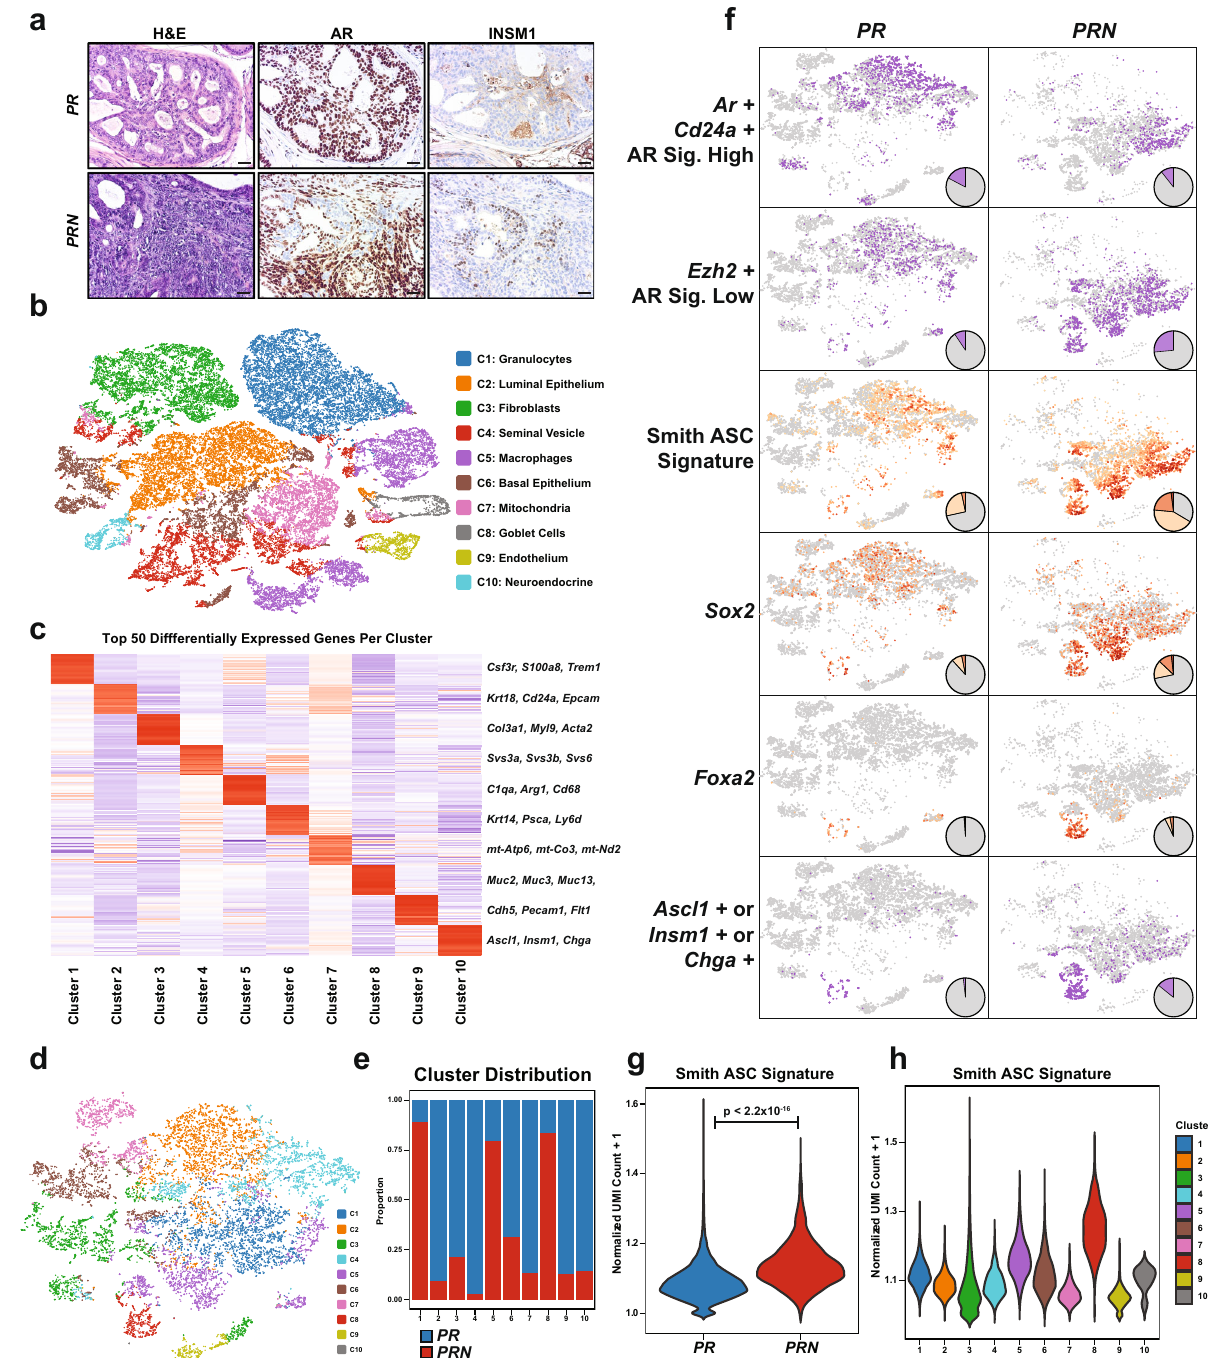
Fig. 3 Single cell-based approaches reveal NEPC-like subpopulations. a H&E and IHC staining of AR and INSM1 in samples used for scRNA-seq. Scale bar: 50 μ m. b The combined t-SNE plot of scRNA-seq data from intact PR ( n = 3) and PRN ( n = 3) mice. c Clustering of the top 50 most differentially expressed genes between clusters. d Reclustering of combined luminal, basal, and neuroendocrine populations from PR ( n = 3) and PRN ( n = 3) mice. e Distribution of genotypes between clusters identi fi ed in panel d . f Expression of indicated markers or signature in PR ( n = 3) compared to PRN ( n = 3) mice. Pie charts show proportions of positive vs. negative cells or high/medium/low/negative gene expression. g Violin plot of Smith ASC score 25 . h ASC score by cluster from panel d were from PRN tumors compared to 25% from PR tumors. Using gene expression, we identi fi ed a population of cells in PR tumors ( PR mice: 8,151 cells; PRN mice: 5,160 cells) (Fig. 3d). We then that were positive for the luminal markers Ar and Cd24a, as well assessed what proportion of each cluster was comprised of cells as had high levels of AR signaling activity assessed by Fkbp5 from each genotype and found striking differences in composi- expression (17.3% of the total cells) (Fig. 3f). This population was tion (Fig. 3e). For example, we found that 75% of the cells in reduced nearly 2-fold in PRN tumors (10.6% of the total cells) cluster C8, which corresponds to the neuroendocrine population,